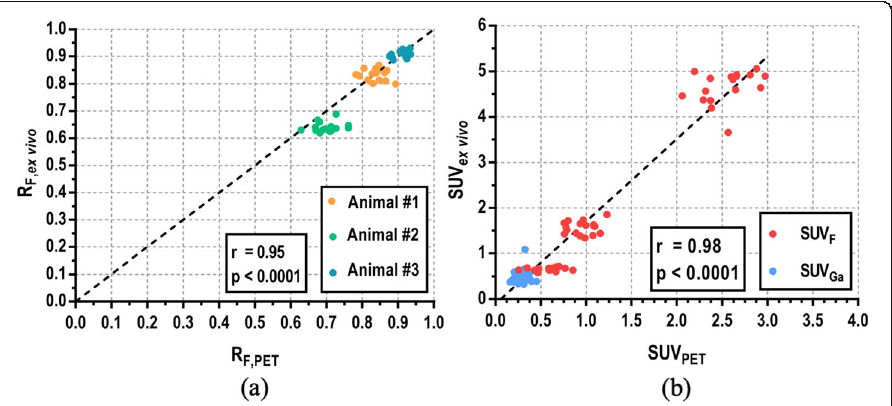
Fig. 8 Linear correlation between relative activities for 18 FDG ( a ) and between SUVs for both 18 FDG and 68 Ga- DOTA ( b ) obtained from multi-tracer compartment modeling at imaging endpoints ( R F,PET , SUV PET ) and from excised tissue ( R